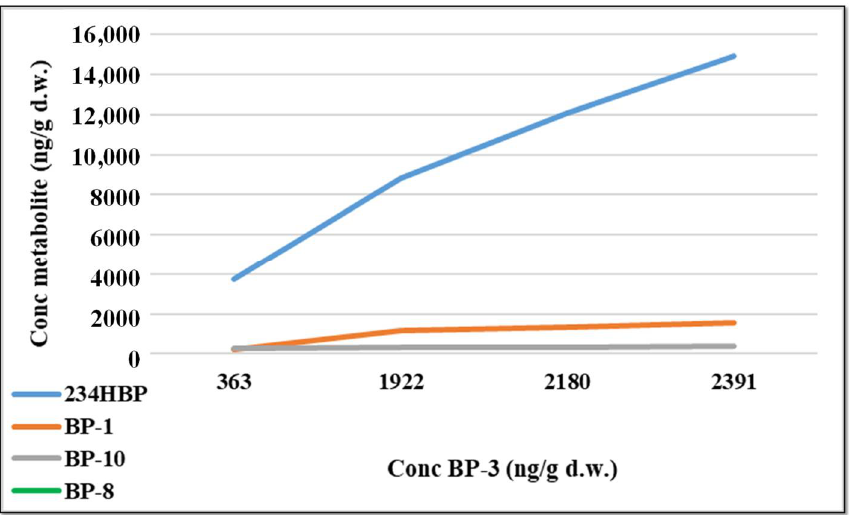
Figure 2. Variation in concentration of identified metabolites compared to the evolution of the BP-3 concentration, in fish.